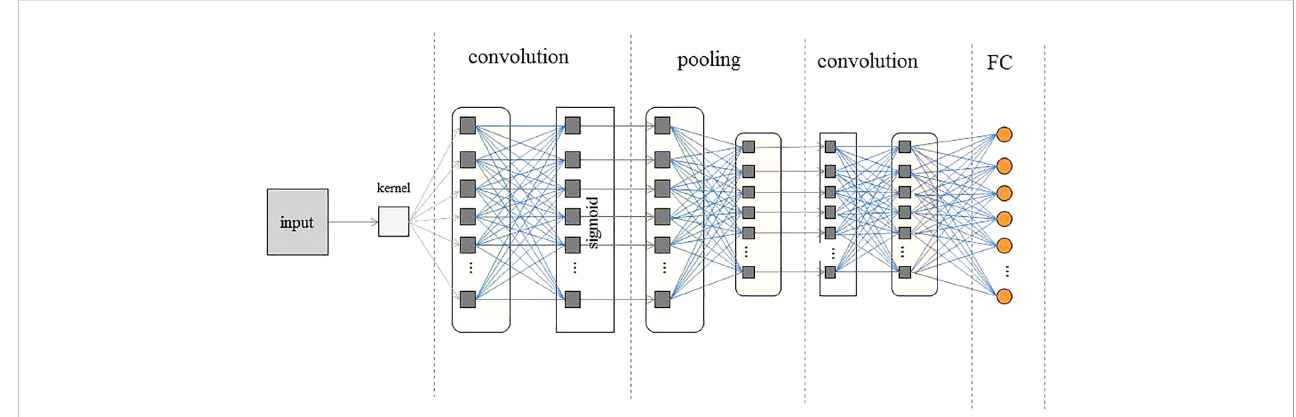
FIGURE 2 An example structure of a